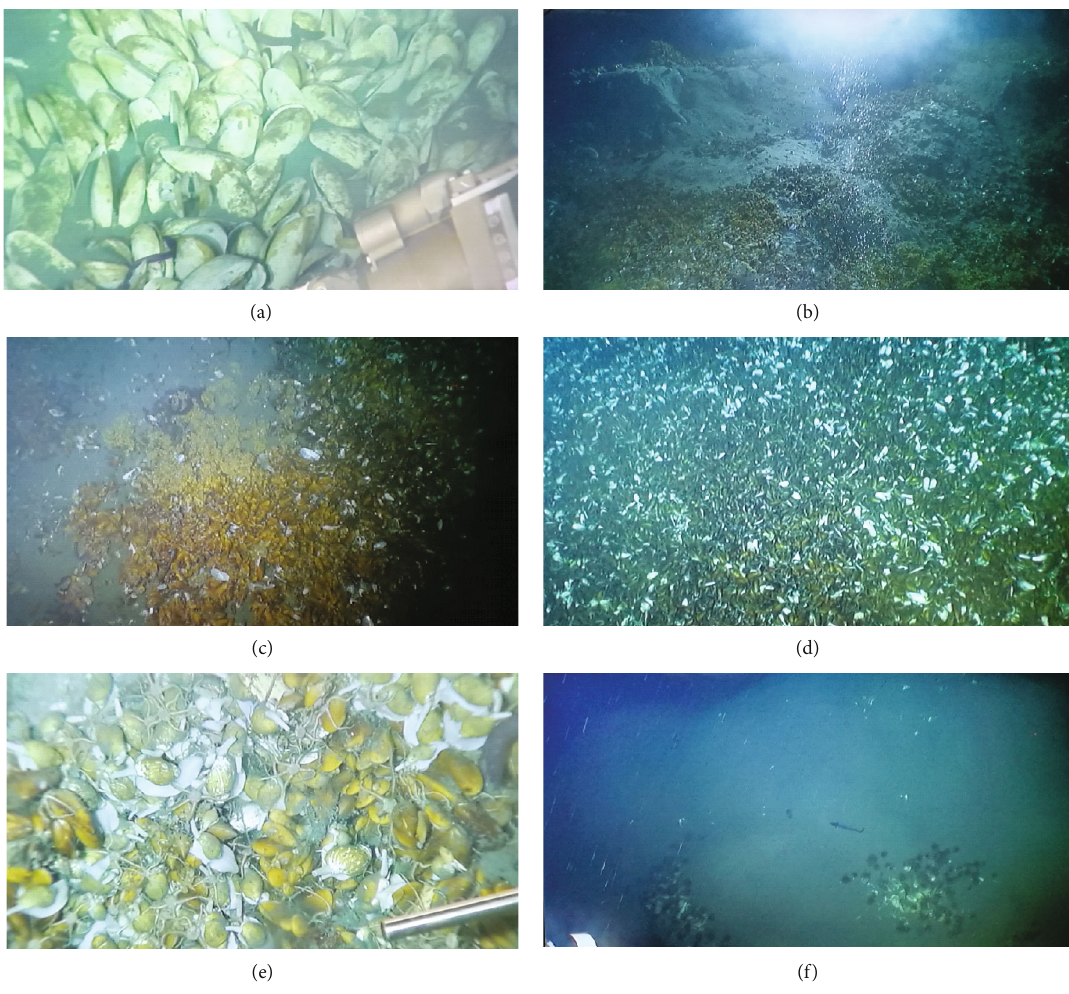
Figure 2: Sea fl oor observations at di ff erent stations taken by ROV: (a) dead clams at station A, (b) continually fl owing plume in HM-ROV-1, (c) numerous mussels around HM-ROV-1, (d and e) abundant mussels around HM-ROV-2, (f) submarine mud dome near HM-ROV-2. Table 1: Ratios of Na + /Cl - , K + /Cl - , Mg 2+ /Cl - , and Ca 2+ /Cl - at di ff erent